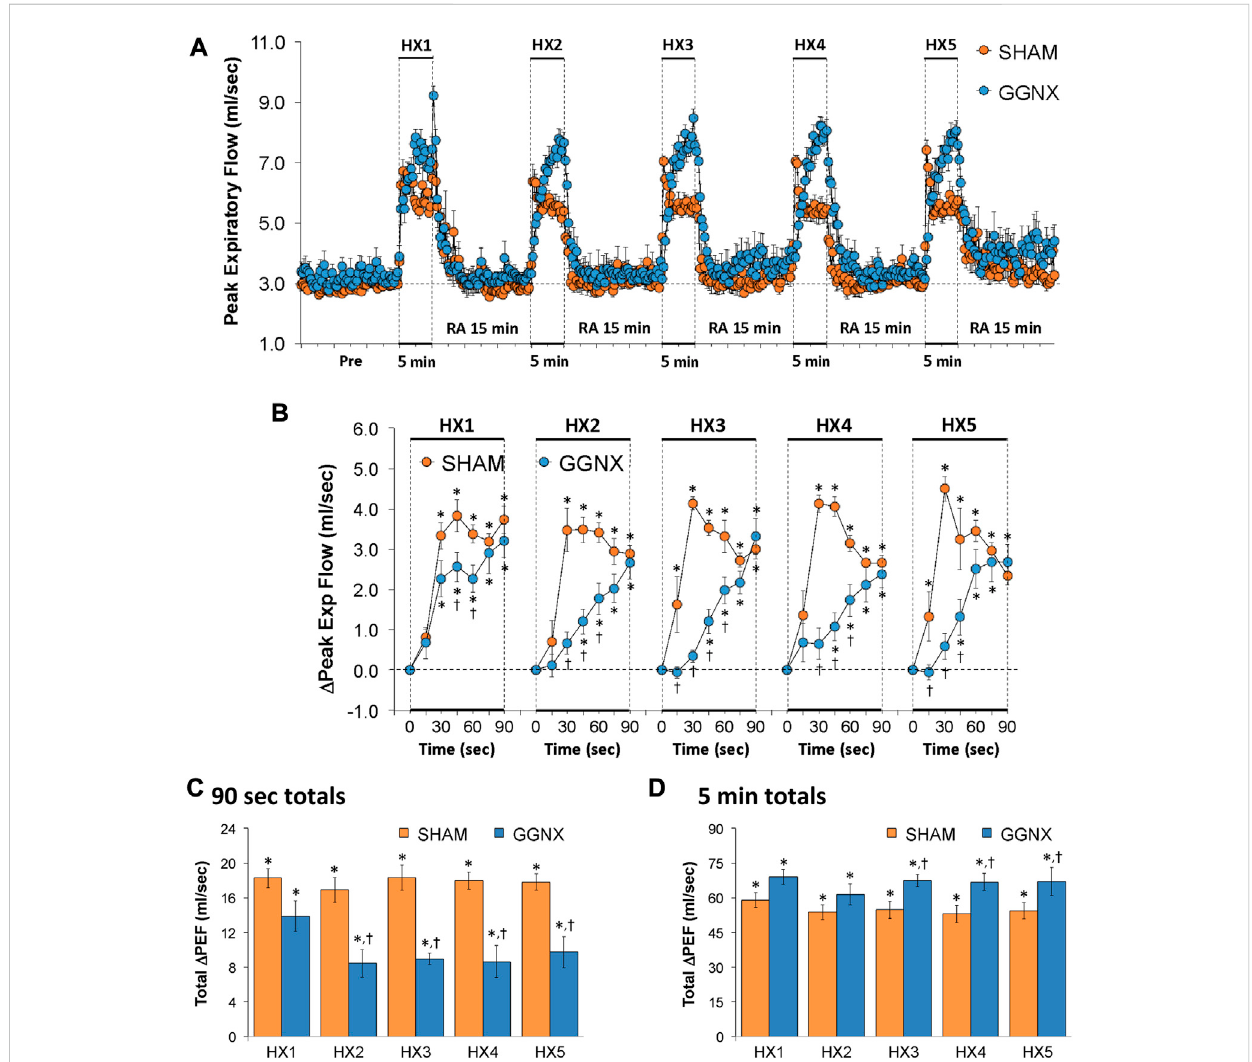
Figure 12B. The total responses recorded over the fi rst 90 s of Figure 12C. The total responses recorded during the entire 5 min of HXC 1-5 were similar in the SHAM and GGNX rats Figure